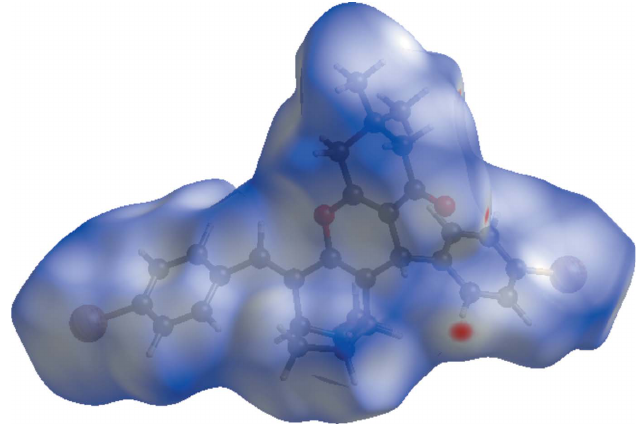
Figure 7 A view of the Hirshfeld surface mapped over d norm in the range (cid:4) 0.1162 to +1.5964 arbitrary units for compound (II).